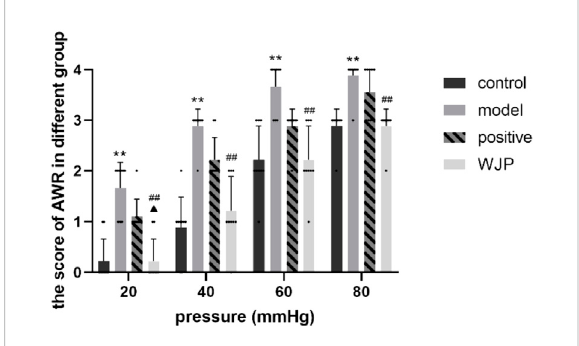
FIGURE 5 Comparison of AWR score. * p < 0.05; ** p < 0.01, versus